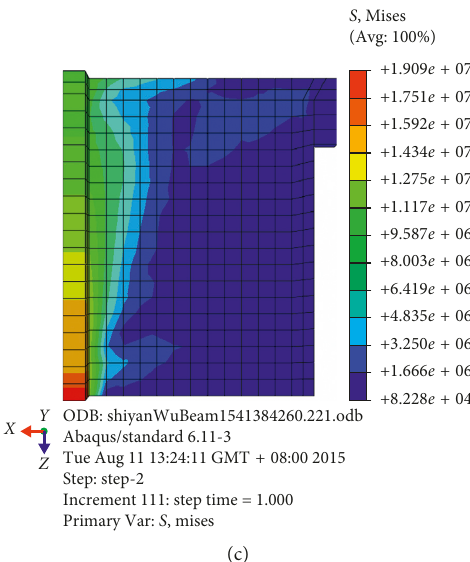
Figure 23: Concrete stress distribution on the NPGCS finite-element spatial model. (a) Concrete stress distribution of the NPGCS finite- element spatial model. (b) Concrete stress distribution on 1st floor web compressed panel of the NPGCS finite-element spatial model. (c) Concrete stress distribution on 1st floor flange compressed panel of the NPGCS finite-element spatial model.